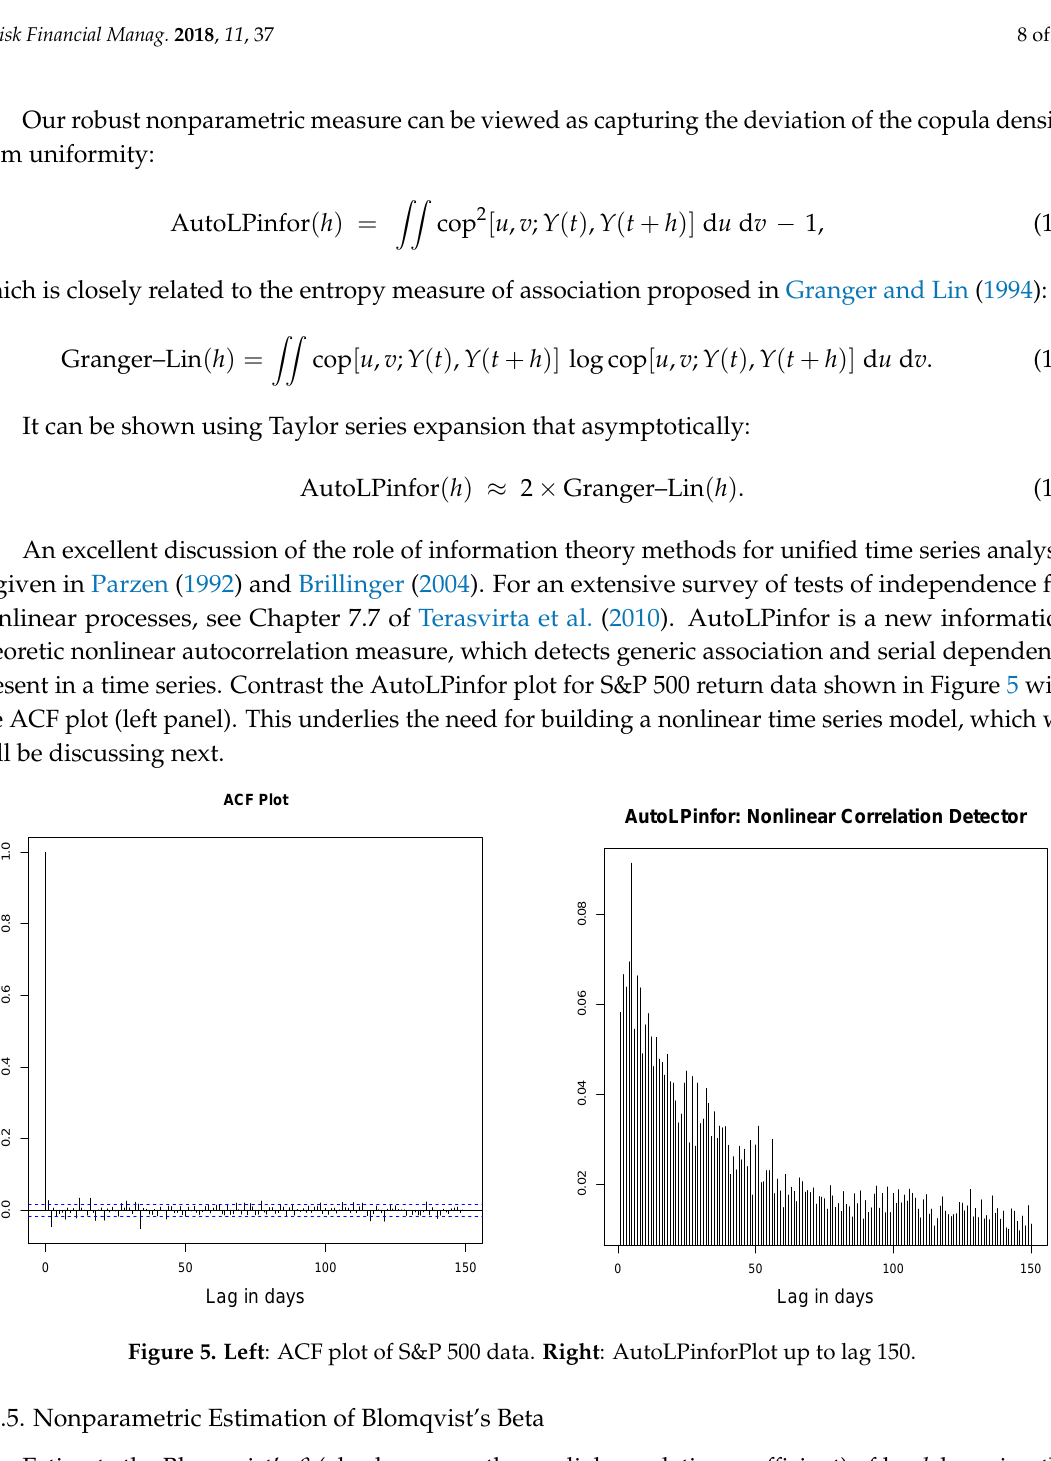
: Normalized distance of copula distribution Cop ( u , v ) from independence copula uv AutoLPinfor : Distance of copula density cop ( u , v ) from uniformity